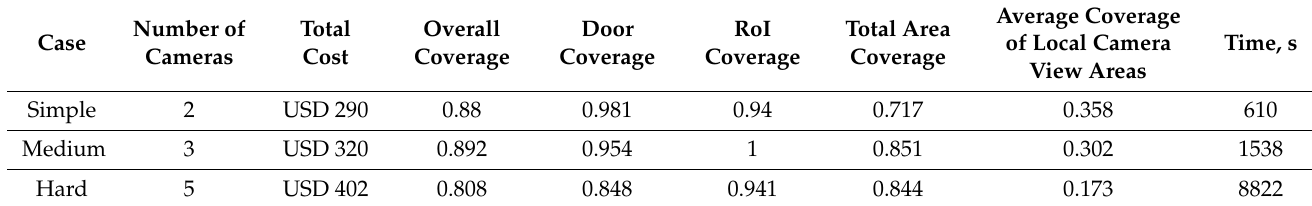
Table 10. Comparison of solutions for rooms of varying